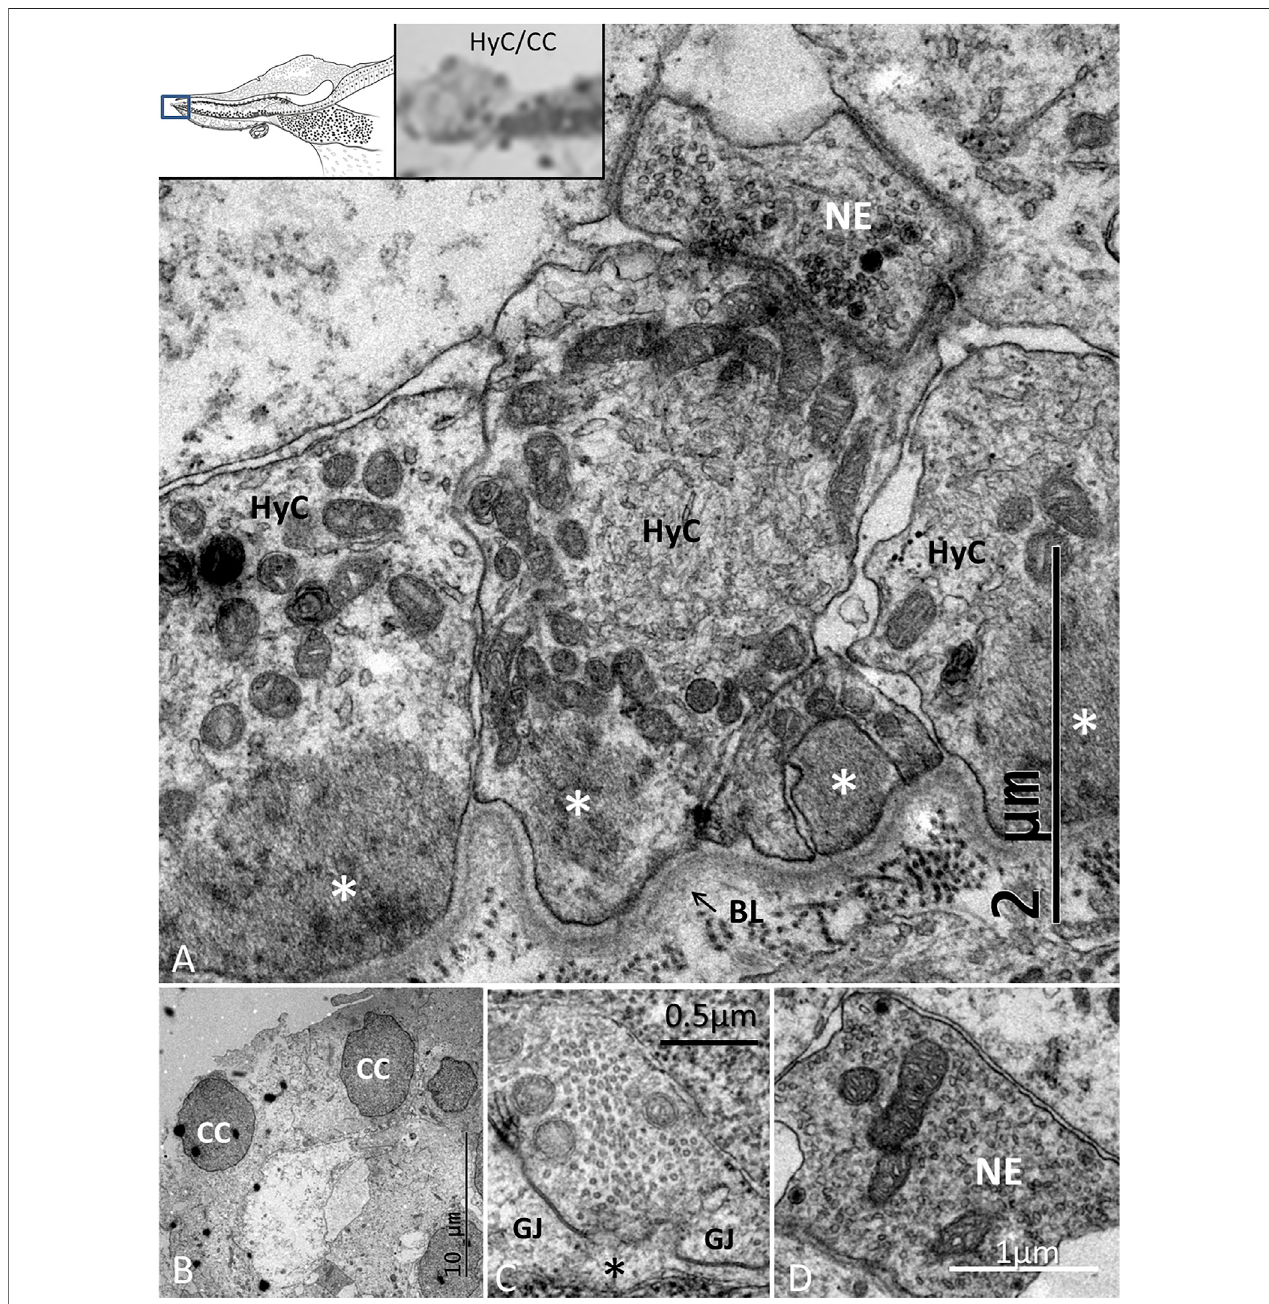
FIGURE9| TEMoftheHyC/CCregion. (A) .HyCsshowbasal fi brillarystructures.AbasallaminaseparatesthecellsfromtheBM.Anerveefferent(NE)connectsto theHyC.Theefferent fi bercontainsanabundanceofclearsecretoryvesicles(inset)andDCVs. (B) .CCswithanintercellularvacuole. (C) .Onecellcontainsmicro-tubules near the plasma cell membrane margined by GJ complexes. (D) . NE associated with an HyC.